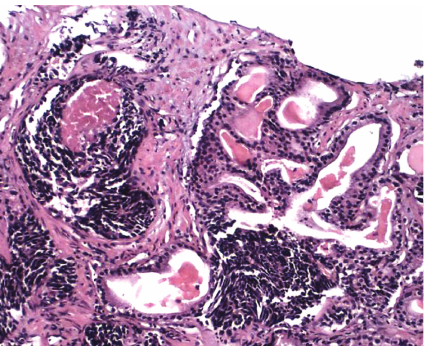
Figure 3: The same case as in Figure 2. Note gradual merging of small cell carcinoma with glands of acinar